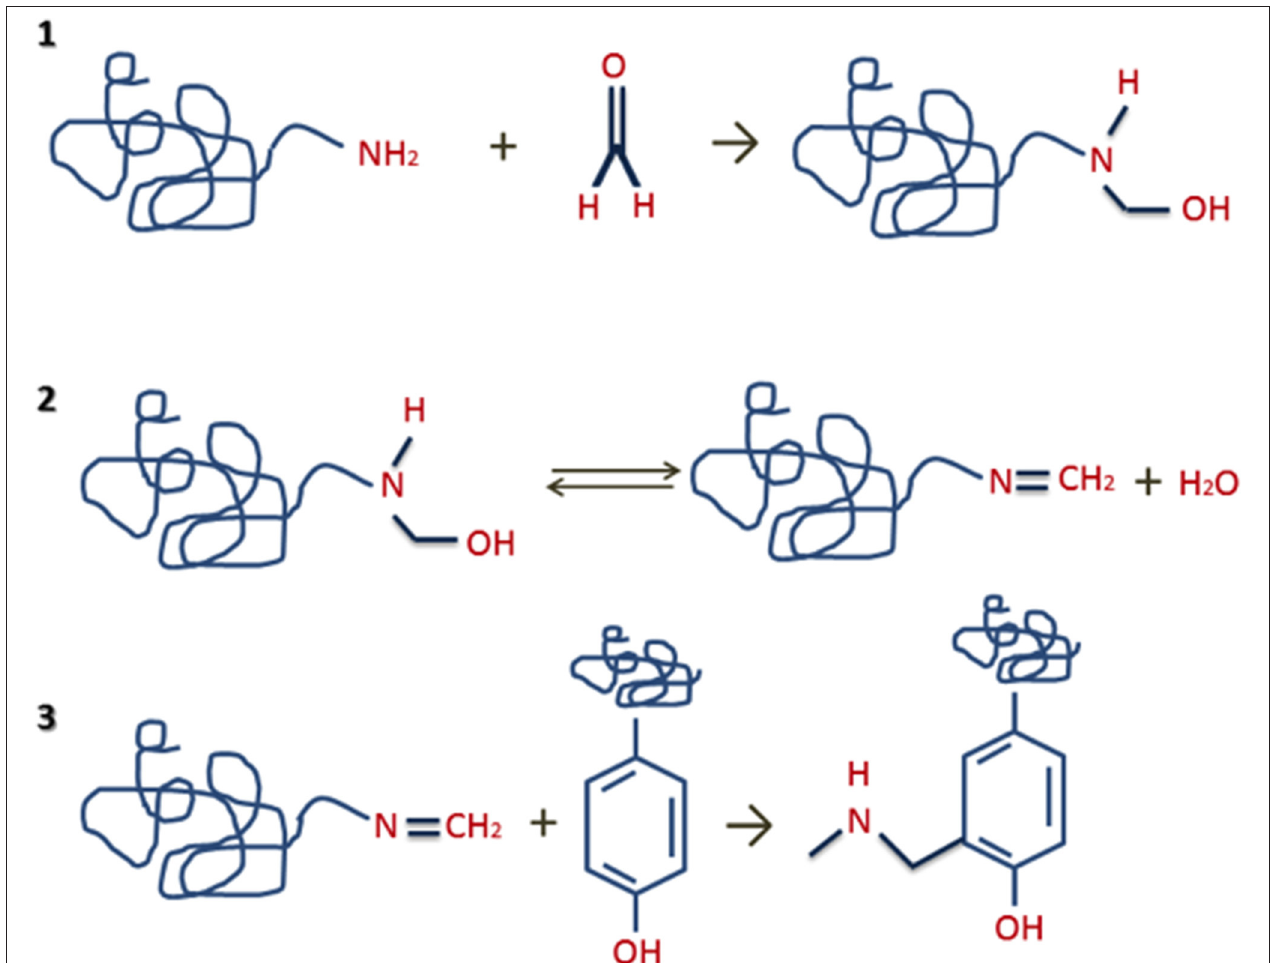
FIGURE 1 | Formation of protein crosslinks steps: (1) reaction of formaldehyde with proteins/peptides to generate unstable methylol groups; (2) interaction of methylol groups with proteins/peptides to form Schiff bases through the elimination of water; (3) interaction of Schiff bases with proteins/peptides to form stable intra- or intermolecular “methylene